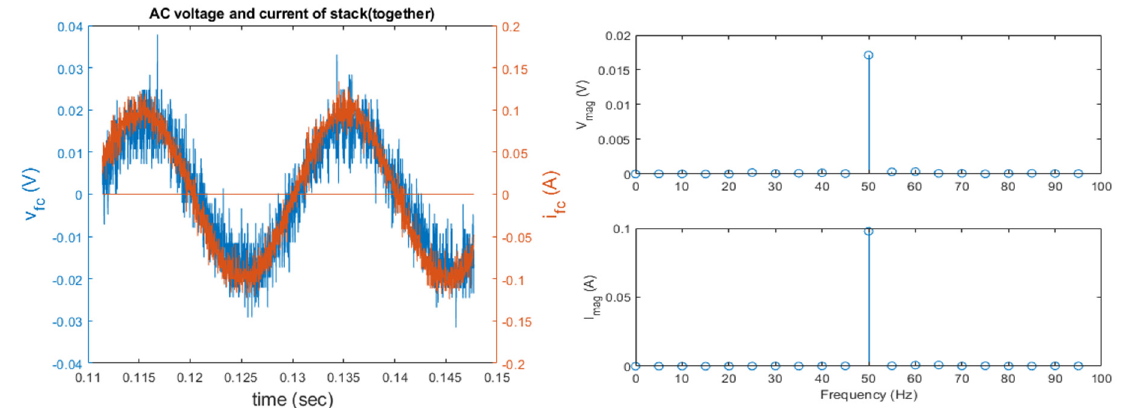
Figure 12. Waveform and spectrum of AC component voltage and current (50 Hz).